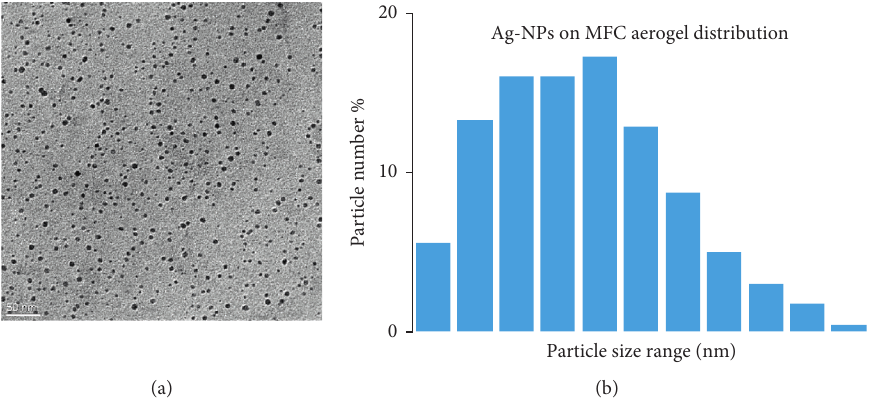
Figure 3: TEM images of MFC/CH aerogel-loaded Ag-NPs. 20% CH (a) and particle size range